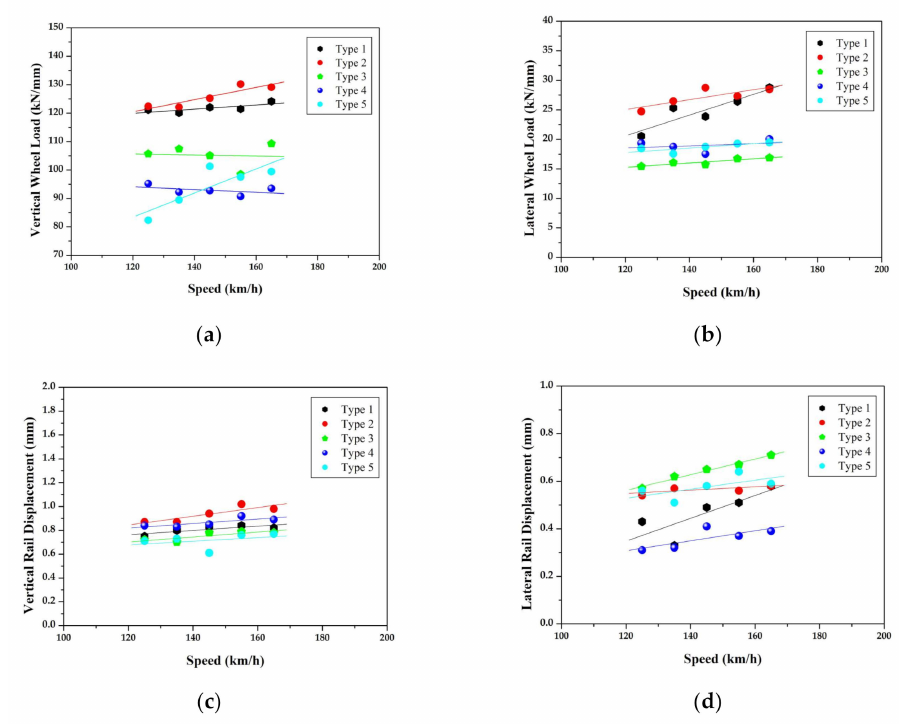
Figure 6. Trackside measurement result comparison for ballasted track types: ( a ) wheel load, ( b ) lateral wheel load, ( c ) vertical rail displacement, and ( d ) lateral rail displacement.